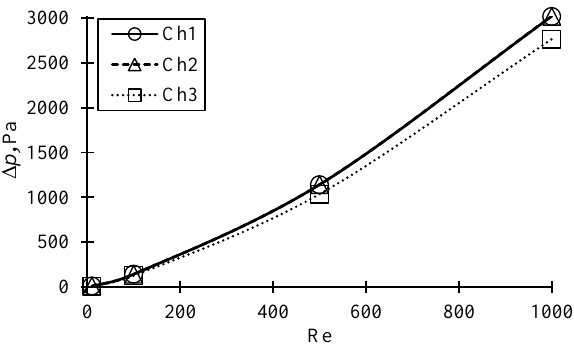
Figure 10. Pressure drop in Ch1, Ch2 and Ch3.